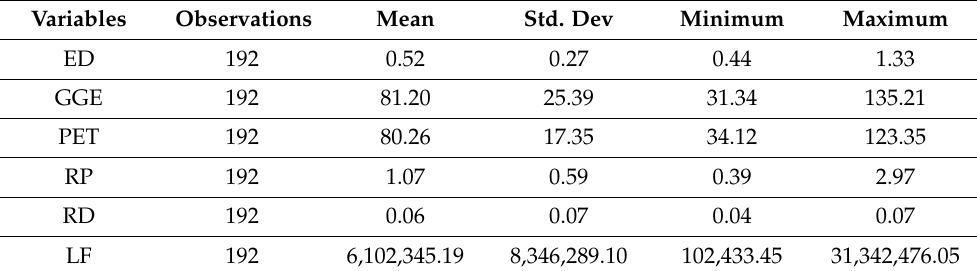
Table 2. Country-level control